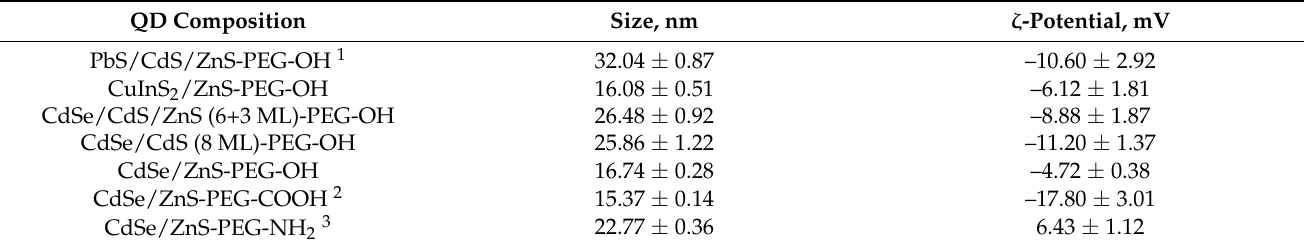
Table 2. Sizes and surface charges of the QDs used in this study.